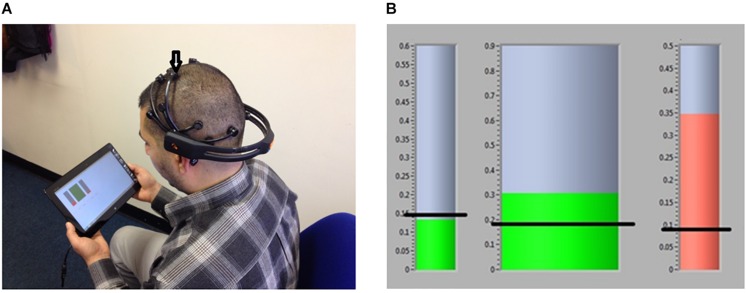
(A) A member of the research team (who consented that his photo is provided) demonstrate the correct location of the EEG headset with an arrow pointing to the electrodes from which the EEG was provided. (B) Neurofeedback GUI; Horizontal black lines present an example of threshold values, they were not shown to users.